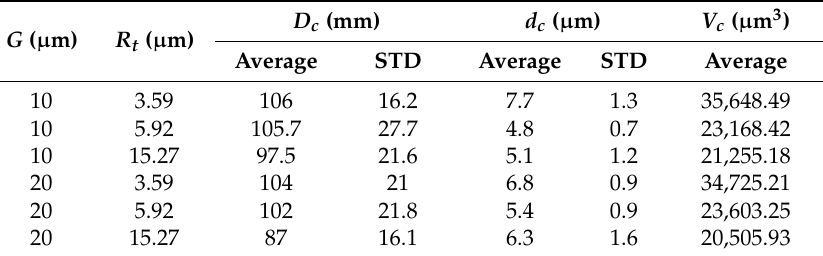
Table 3. Crater dimensions vs. part initial roughness and theoretical gap